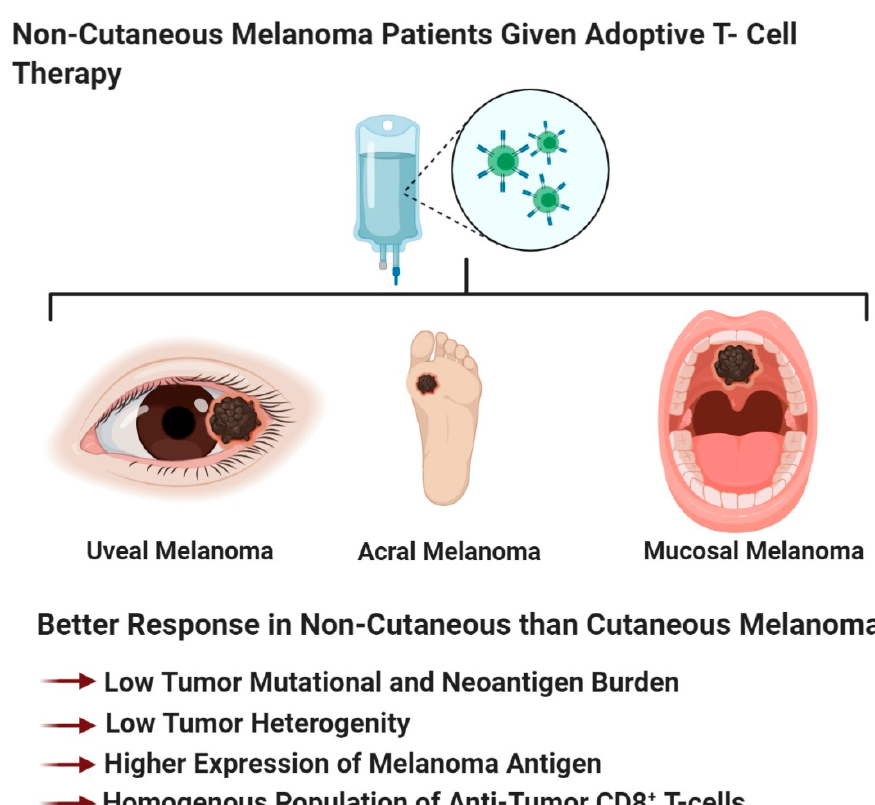
Figure 6. Non-cutaneous melanoma patients benefit from adoptive T-cell therapy better than cutaneous melanoma patients. Created with BioRender.com.